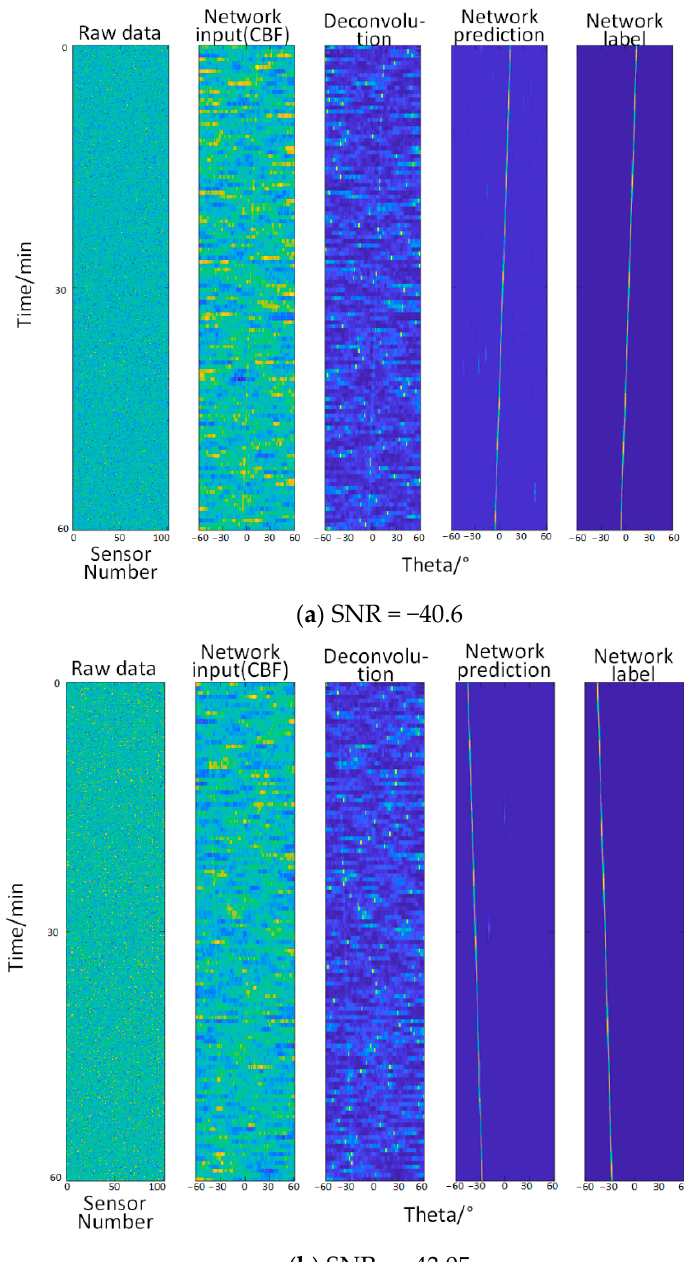
Figure 5. Comparison of angle recognition results of different methods for different levels of signal ‐ to ‐ noise ratio. From left to right: original data (the abscissa is the sensor number, and the ordinate is the time), the input of the network (the abscissa is the angle, and the ordinate is the time, which is the same below), deconvolution method, network prediction, network label (true trajectory).